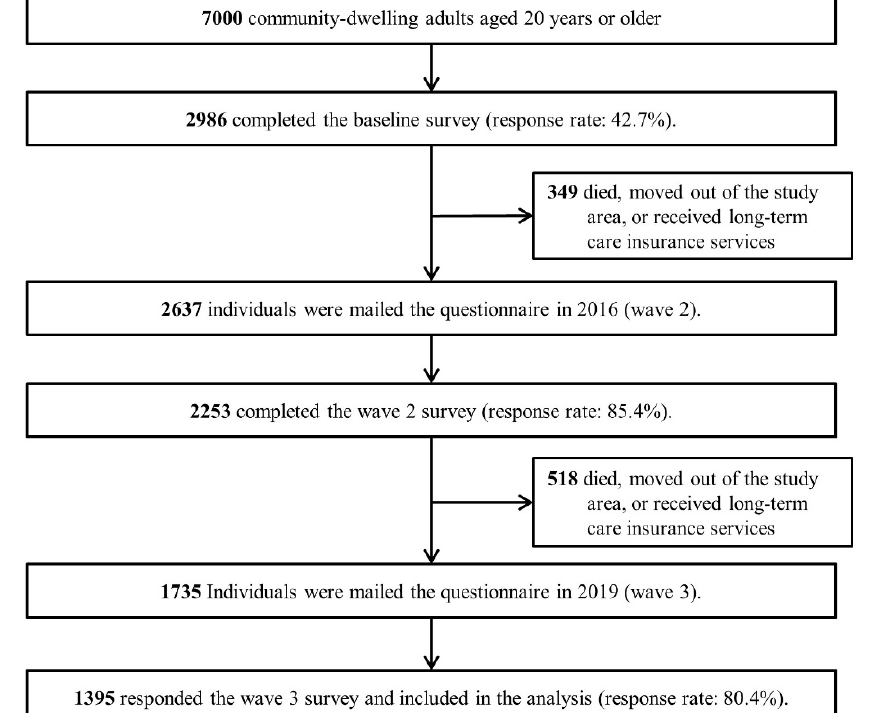
Figure 1. Flow diagram of this study.